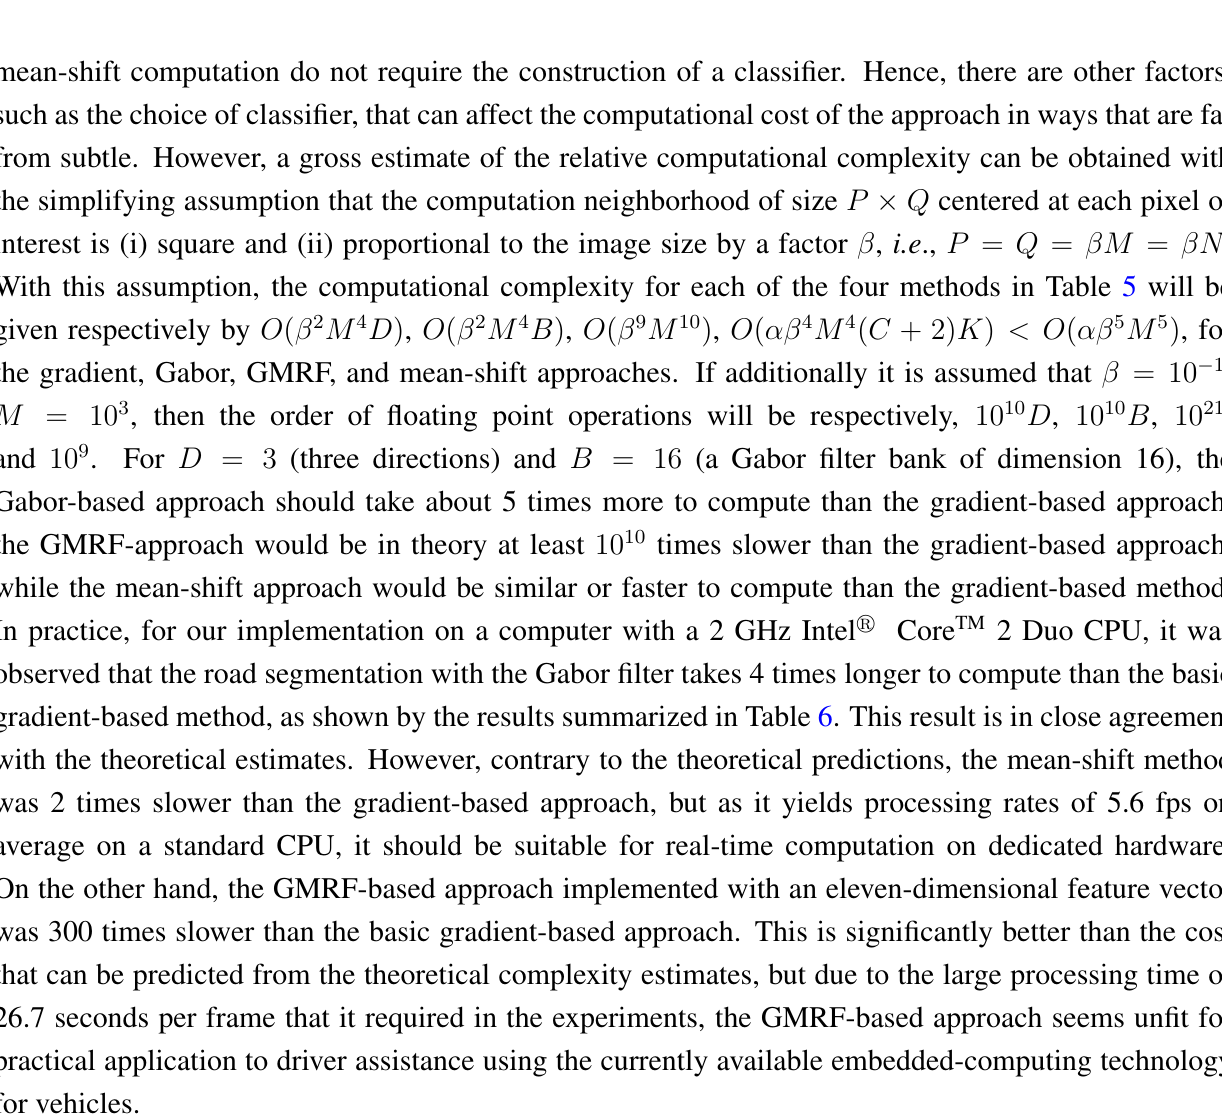
Table 6. Comparison of the computational time of lane detection and